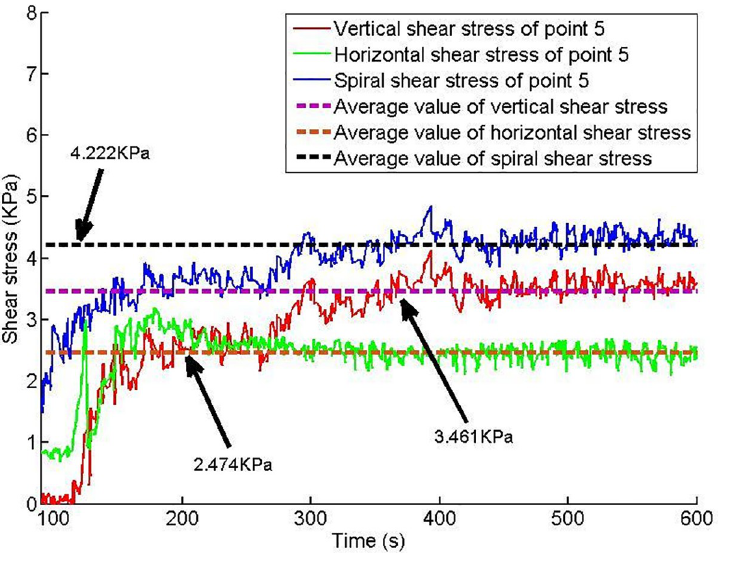
Fig 17. Shear stress of testing point